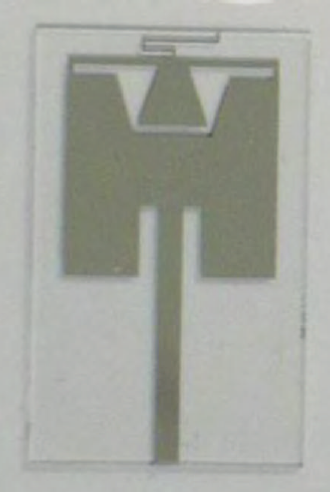
Figure 4: Frequency switchable antenna based on MEMS technol- ogy [7].